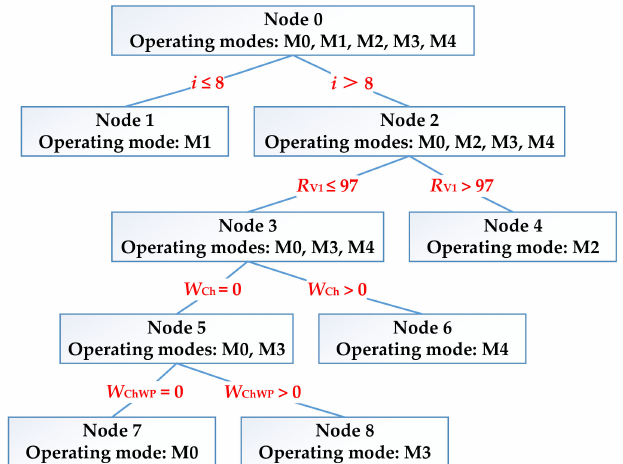
Figure 3. Decision-tree classification model for recognizing operation